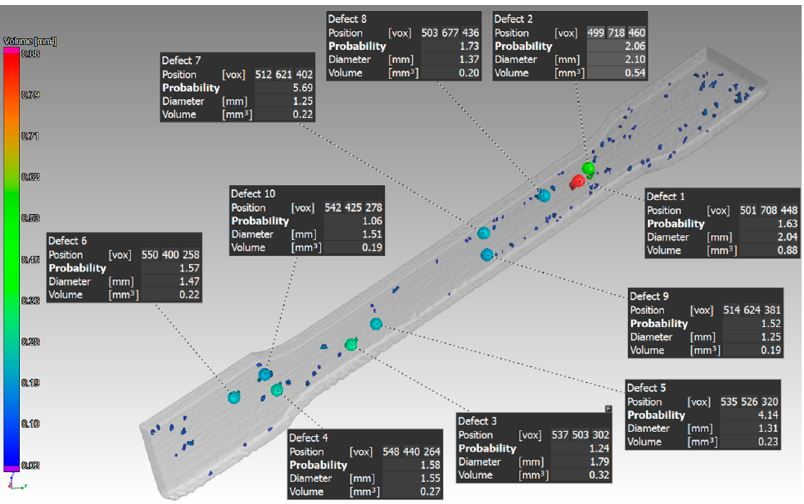
Figure 12. Specific defects on a sample with 2 mm thickness, which was oriented XZ.